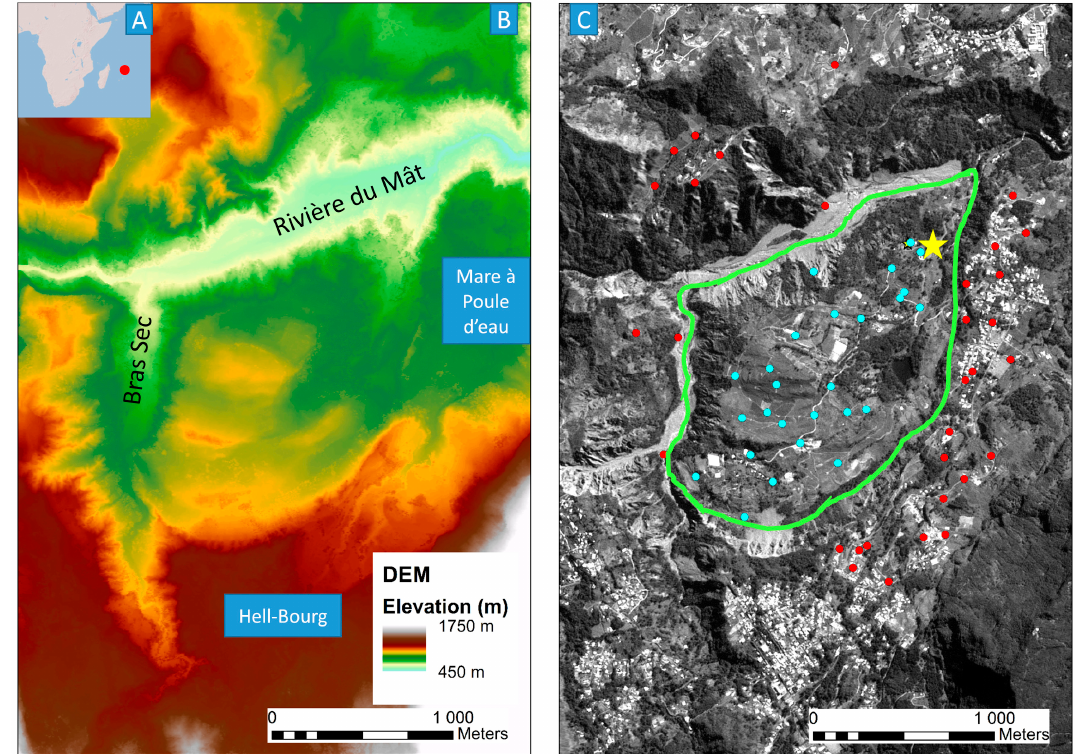
Figure 1. ( A ) Réunion Island in the Indian Ocean; ( B ) DEM of the study area at a 5 m resolution in the Salazie erosion watershed. The “Mare à Poule d’Eau” landslide is bordered to the north by the “Rivière du Mat”, to the west by the “Bras Sec” gully. The Hell-Bourg plateau dominates the south border of the landslide along a 120 m high cliff; ( C ) Ortho-rectified SPOT-5 image of the study area at a 2.5 m resolution acquired in 2008. The green line shows the limits of the landslide. The red and turquoise points indicate the position of the ICP (Image Control Points) used to validate the correlation. The DGPS station of Vira is indicated by the yellow star.